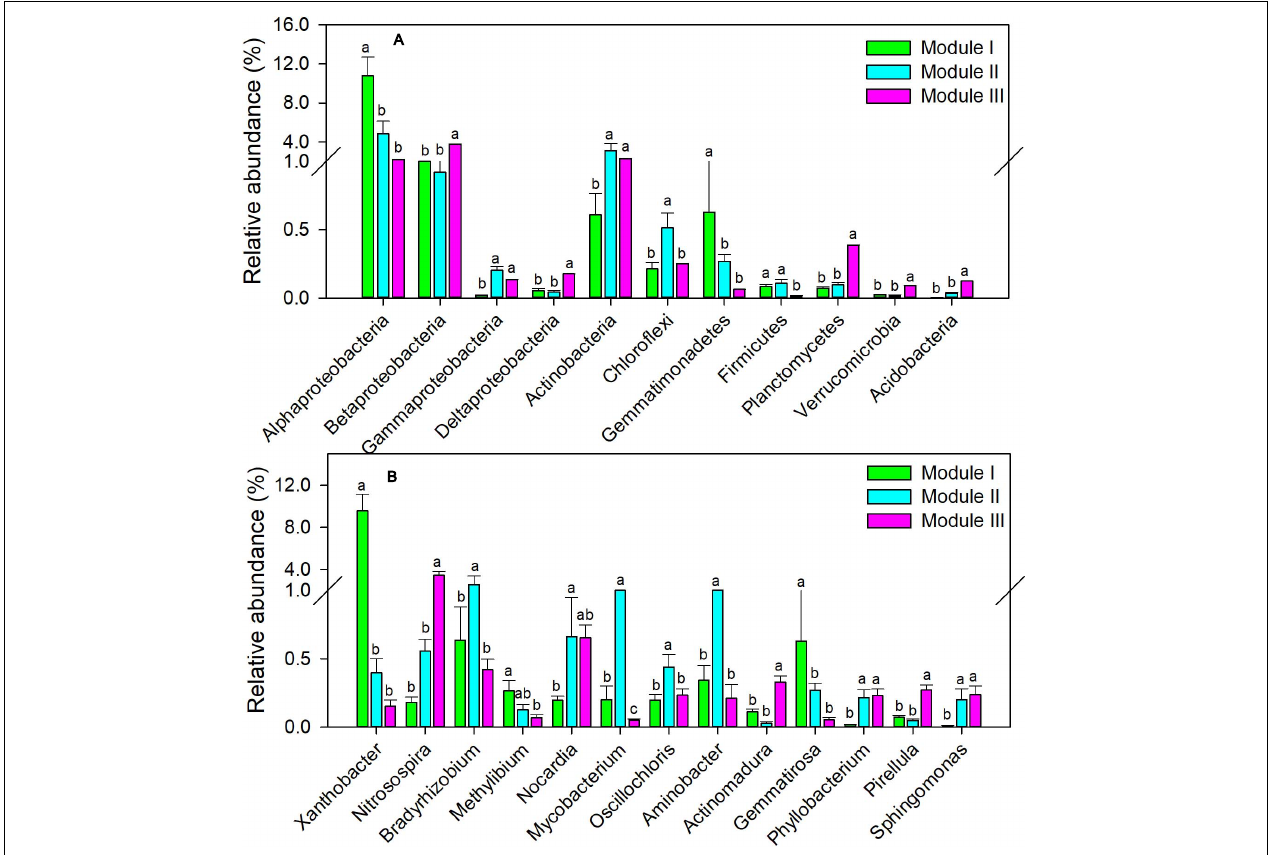
FIGURE 4 | Relative abundance of different dominant modules in soil autotrophic bacterial networks at phylum (A) and genera (B) levels. Different small letters indicate the significant difference among modules at P < 0.05. Bars represent standard errors ( n = 15).